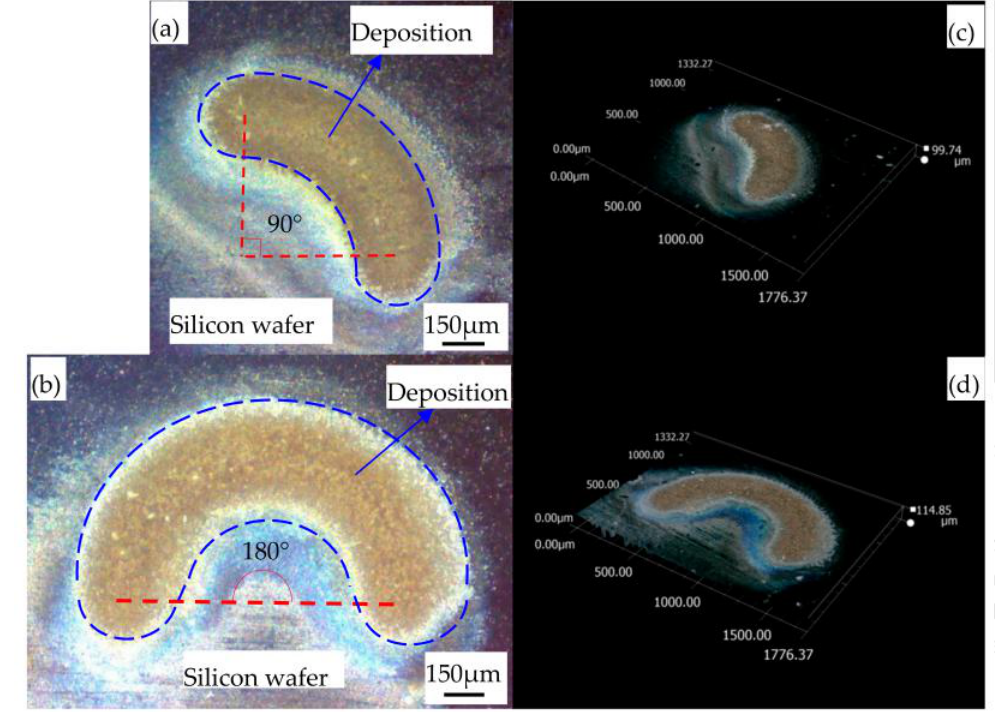
Figure 15. Example of HV- µ EAM metal layer ( a ) trajectory deposition e ff ect of 90 ◦ , ( b ) trajectory deposition e ff ect of 180 ◦ , ( c ) and ( d ) are the photos of depositions observed by Ultra Depth of Field 3D